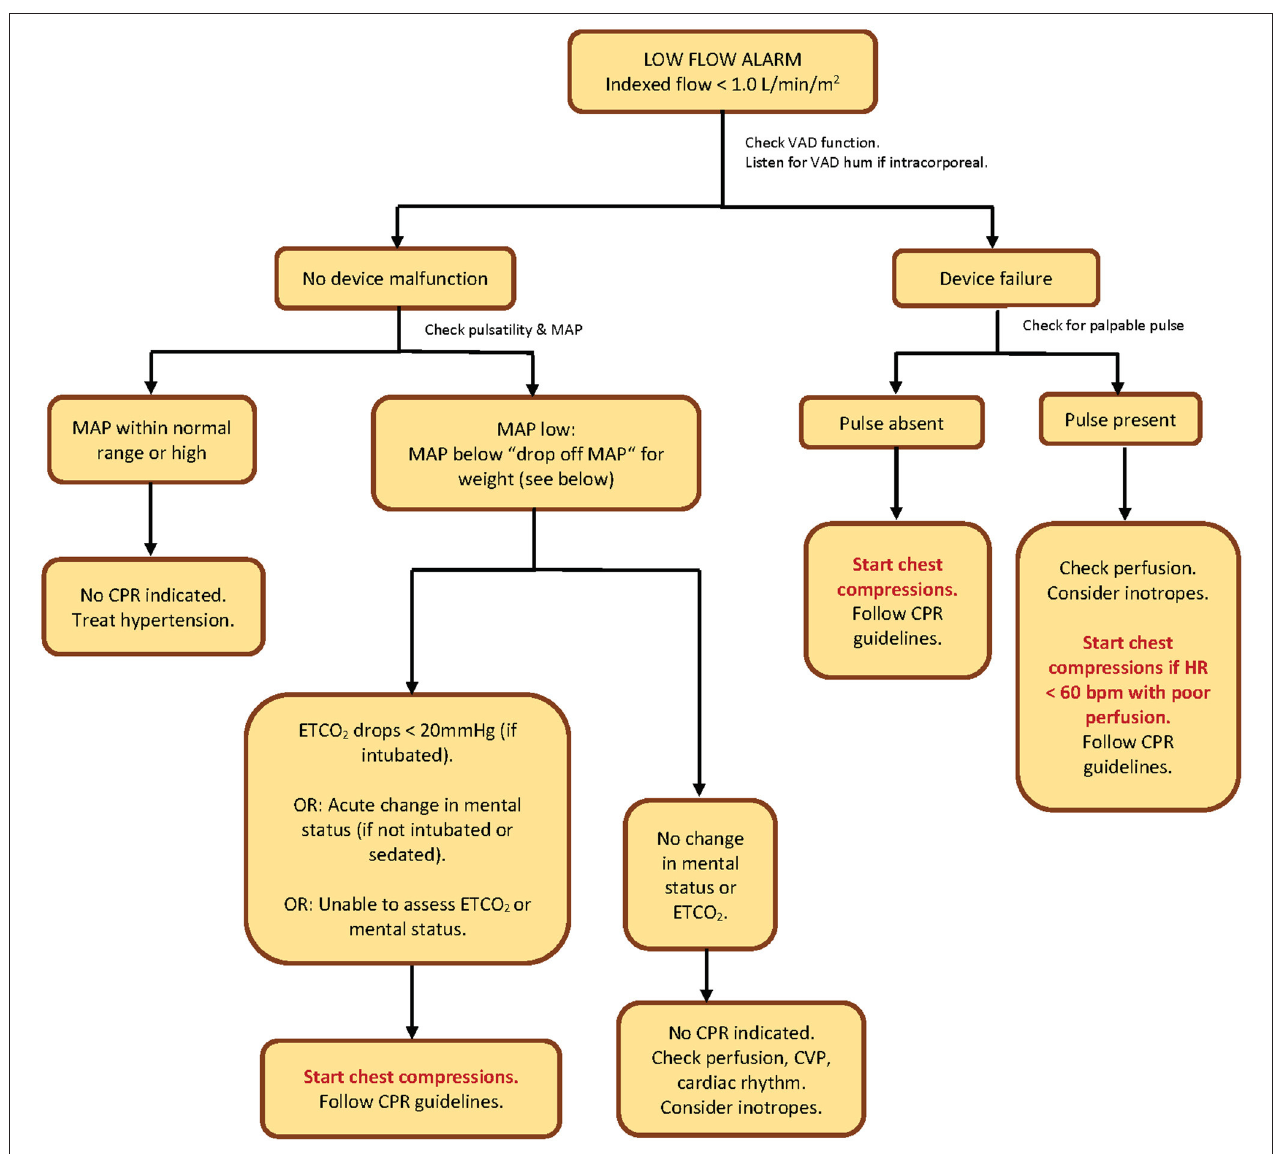
FIGURE 1 | CPR algorithm to determine initiation of chest compressions in pediatric patients with continuous-flow ventricular assist devices in the systemic (left/single) ventricle. “Drop-off MAP” by patient weight: If weight < 15 kg = 25 mmHg; if weight 15–30 kg = 30 mmHg; if weight > 30 kg = 35 mmHg. VAD, ventricular assist device; MAP, mean arterial pressure; CPR, cardiopulmonary resuscitation; ETCO 2 , end-tidal carbon dioxide; HR, heart rate; bpm, beats per minute; CVP, central venous